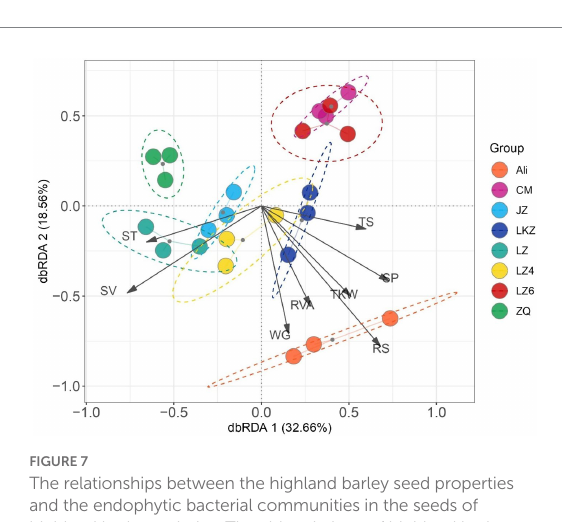
FIGURE 6 Principal coordinates analysis of the endophytic bacterial communities in the seeds of highland barley varieties. CM, Cuomei; JZ, Jiangzi; LZ, Lazi; LZ4, Longzi4ling; LZ6, Longzi6ling; LKZ, Langkazi; and ZQ, Zangqing 2000.